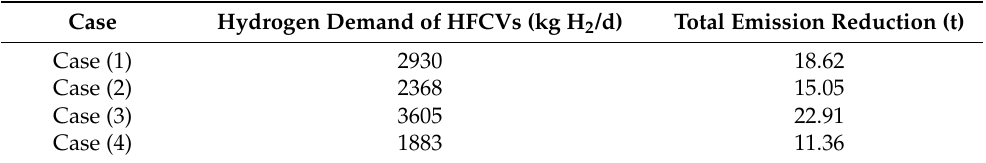
Table 14. Summary of emission reduction of HFCVs for